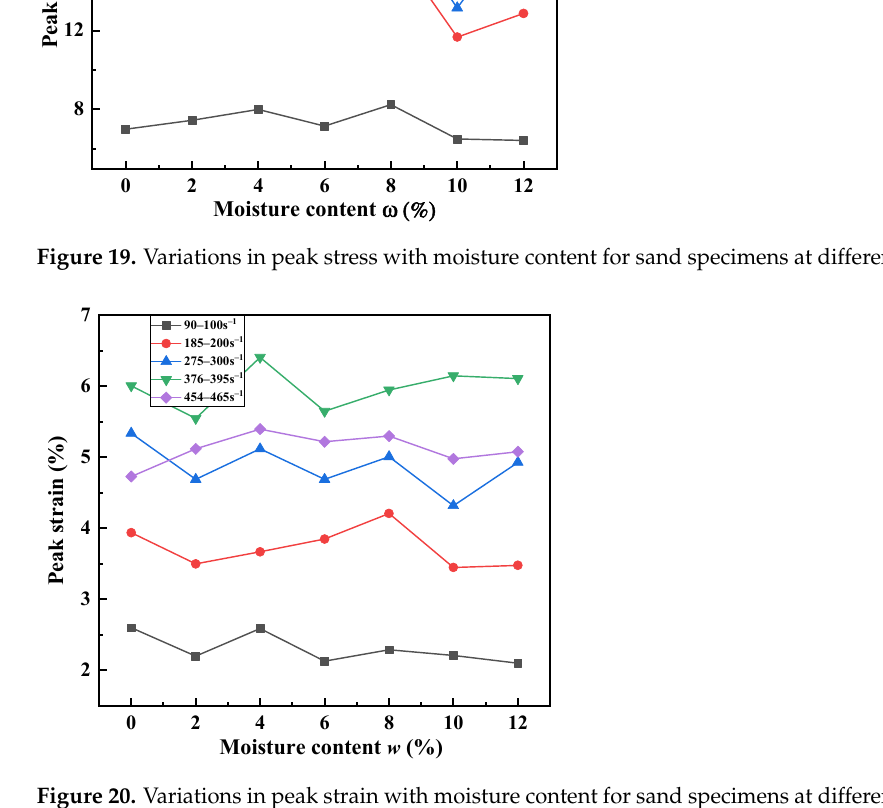
Figure 20. Variations in peak strain with moisture content for sand specimens at different strain rates. Table 3. Saturation and percentage of air volume for a given moisture content.